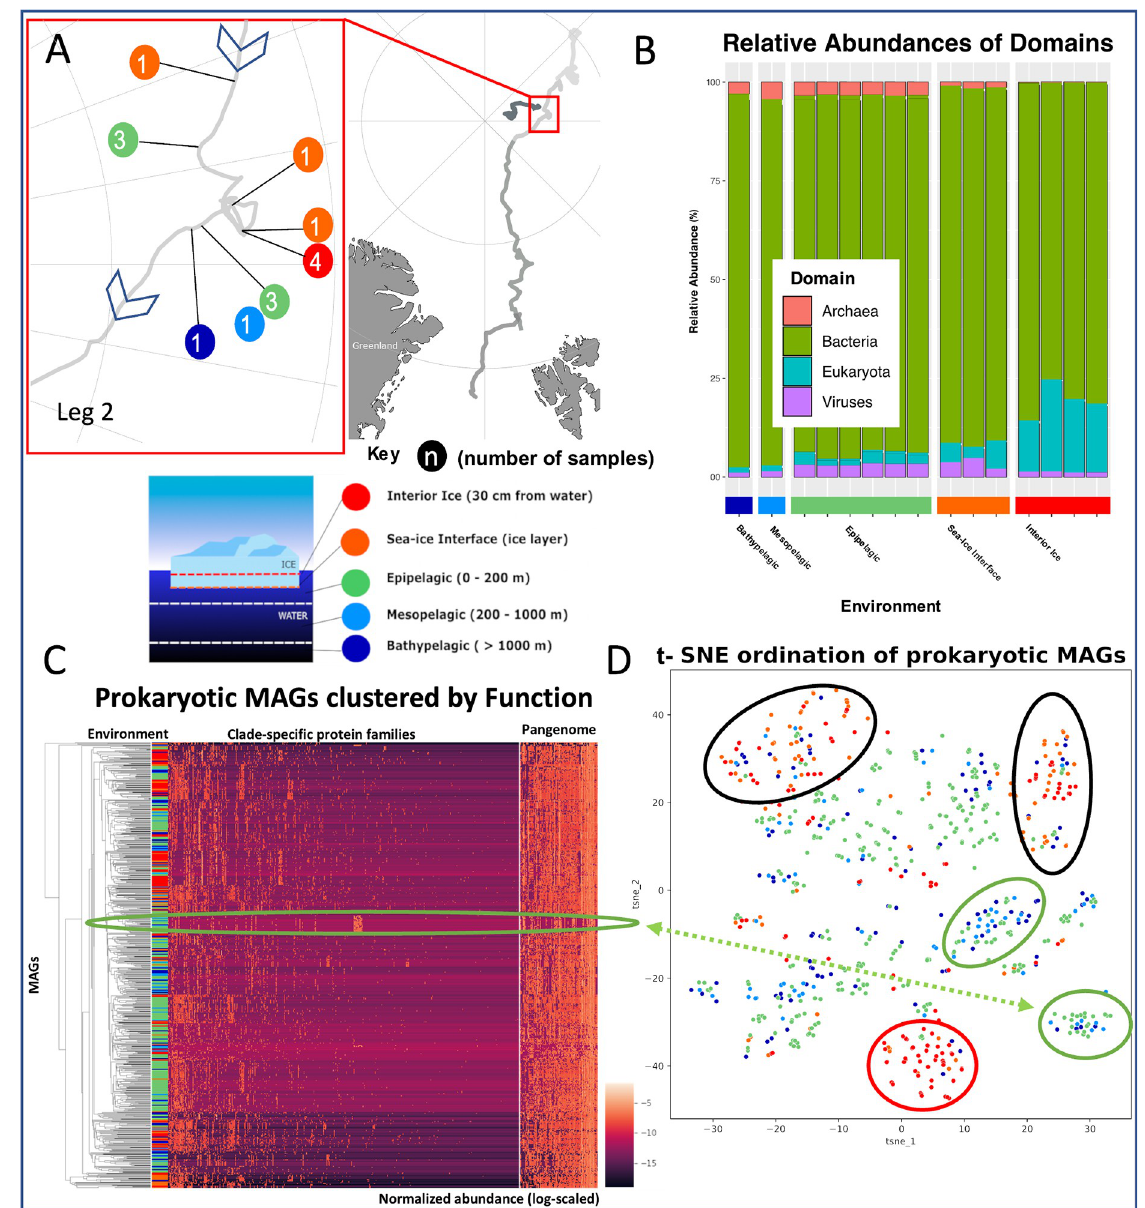
Fig 2. The EcoOmics project. (A) Detailed map of EcoOmics pilot sample sites, taken during Leg 2 of the expedition (December 13– February 24). Samples were collected from 5 different ice and water environments, with 2 epipelagic samples pooled from the other 4 samples. (B) Taxonomic abundances, based on the JGI IMG/M taxonomic annotation pipeline. Samples are dominated by bacteria, with a notable enrichment of eukaryotes in the interior sea ice. These same samples are noticeably lacking archaea. (C) Heatmap showing prokaryotic metagenome-assembled-genomes (MAGs) clustered based on abundances of protein families (Pfams). The highlighted group of protein families are present in significant proportions in a large clade of archaeal MAGs; this group contains a number of ribosome related Pfams specific to archaea. (D) t-SNE ordination to represent environmental filtering for prokaryotic MAGs, based on the abundances of their protein families. A large clade of archaeal MAGs forms a noticeable cluster (bottom right, circled). Some clades are found only in specific environments (green circle = pelagic environment; red circle = sea-ice environment), while others are found more widely such as alpha- and gamma-proteobacteria (black circle = present in all sampled environments). Data used in this manuscript was produced as part of the international Multidisciplinary drifting Observatory for the Study of the Arctic Climate (MOSAiC) with the tag MOSAiC20192020 and the Project_ID: AWI_PS122_00.